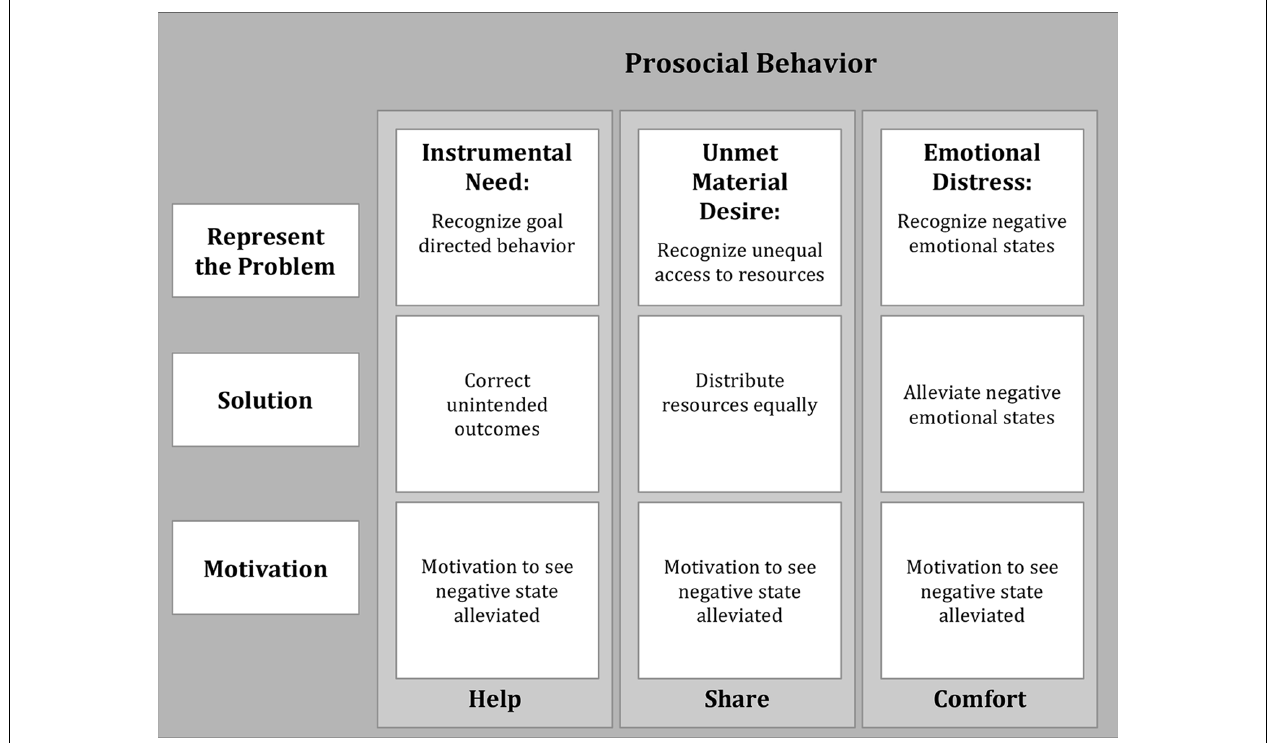
FIGURE 1 | Categorization of prosocial behavior based on the varieties of negative state the child must identify and overcome. An effective intervention will only occur when all three components can be successfully resolved. Different varieties of prosocial behavior show independent developmental trajectories because of the unique social cognitive